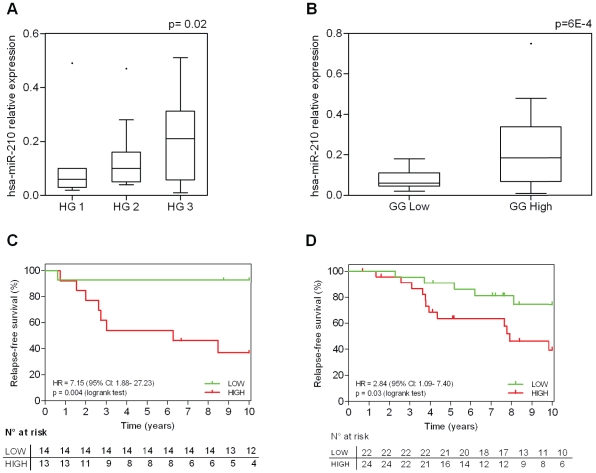
MiR-210 relative expression according to histological grades and genomic grades.The normalized expression levels of miR-210 between histological grades (HG) 1, 2 and 3 (A) and between low and high GGI (GG Low and GG High) (B) assessed by qRT-PCR. Boxes represent interquartile range, black bars indicate the median, points represent outliers. p value is based on one-way Anova test. Kaplan-Meier analyses for relapse-free survival according to miR-210 expression levels in histological grade 2 population. (C) Systemically untreated population (N = 27); (D) Validation ER-positive tamoxifen treated population (N = 46) HR: hazard ratio, CI: confidence intervals.